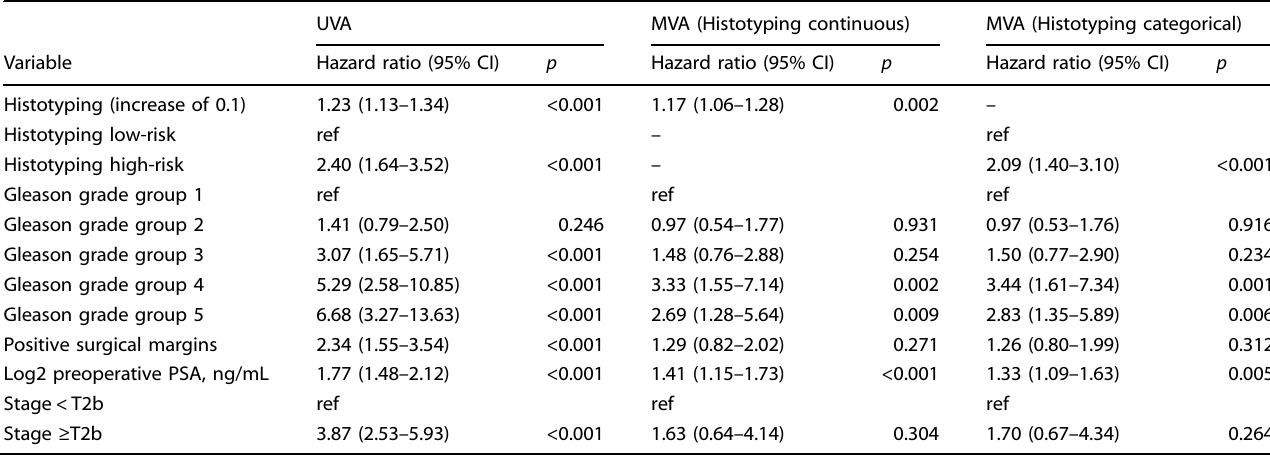
Table 2. Cox proportional hazard univariable (UVA) and multivariable (MVA) analysis of BCR including the Histotyping risk score with Gleason grade group, margin status, preoperative PSA, and pathological tumor stage in n = 648 patients of the validation set with available clinical information. UVA MVA (Histotyping continuous) MVA (Histotyping categorical) Variable Hazard ratio (95% CI) p Hazard ratio (95% CI) p Hazard ratio (95% CI) p Histotyping (increase of 0.1)